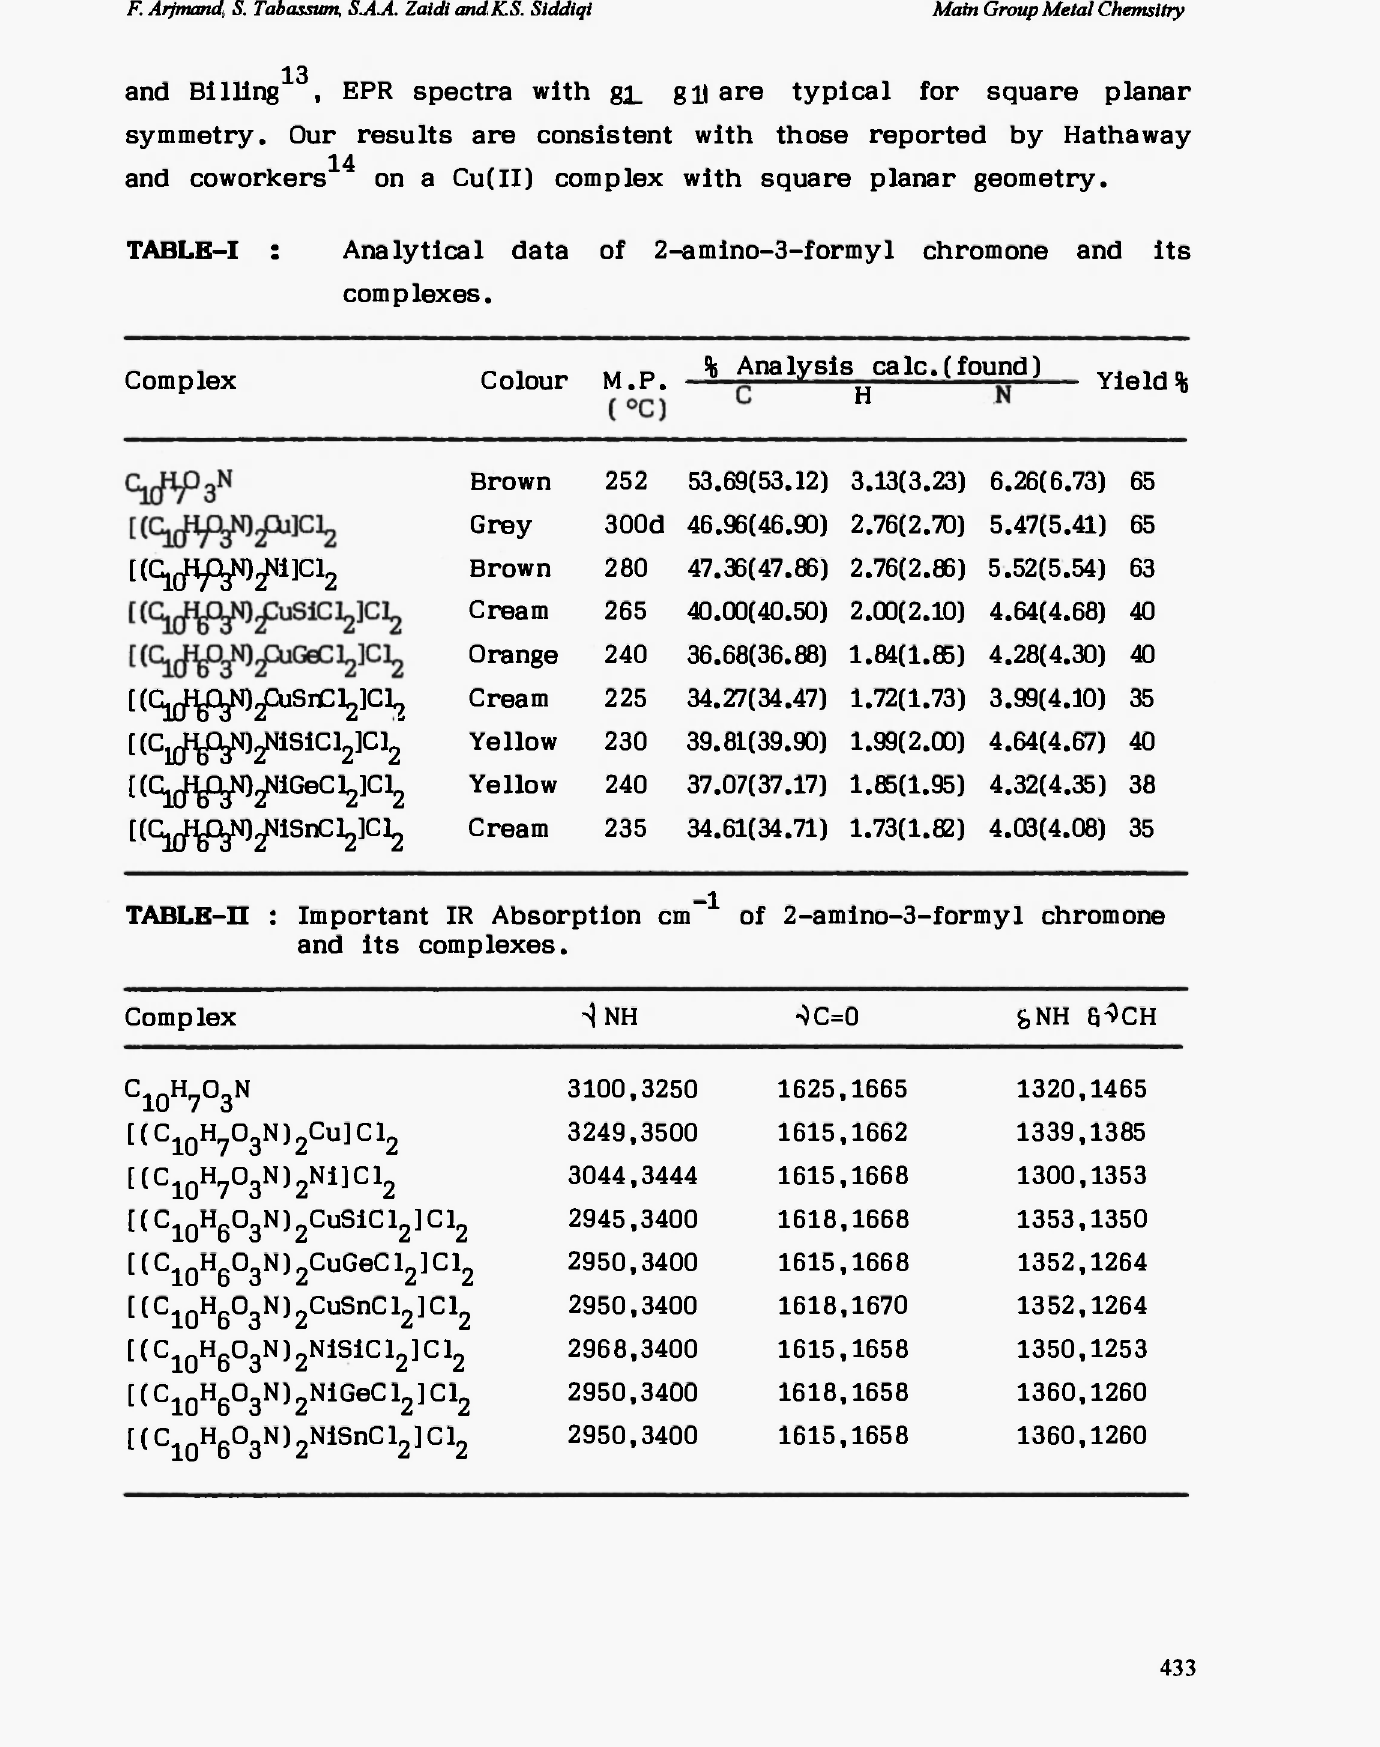
TABLE—I : Analytical data of 2-amino-3-formyl chromone and its complexes.